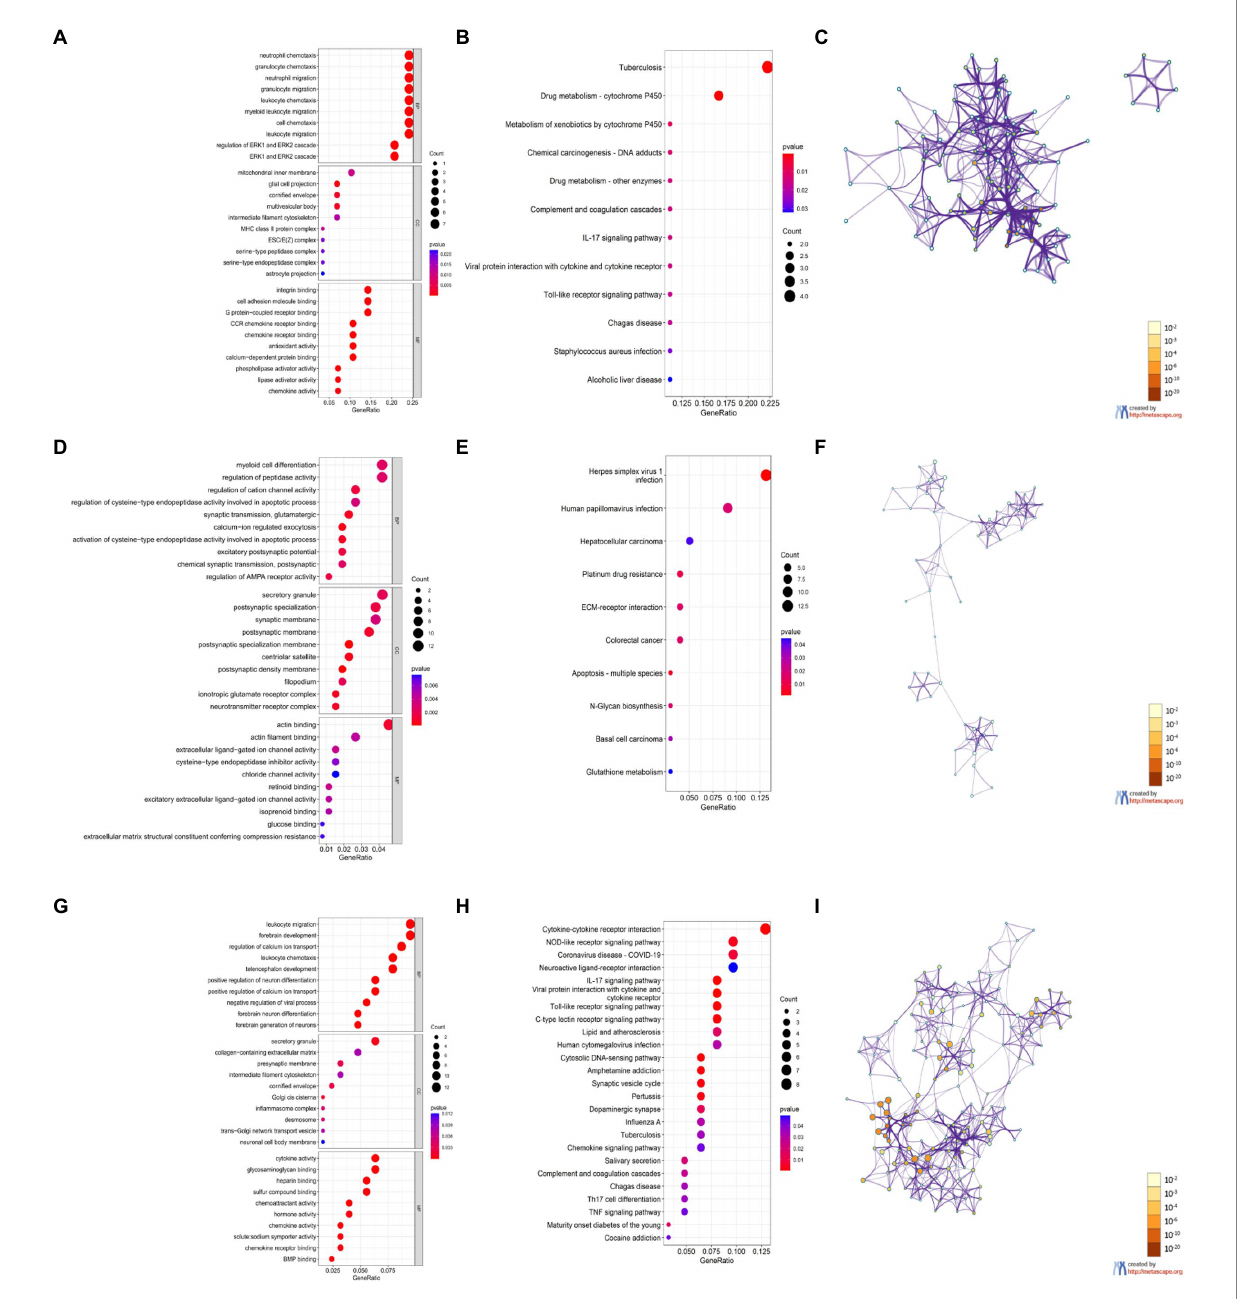
FIGURE 6 Enrichment analysis of DEGs based on R software and Metascape. (A,D,G) GO enrichment items of CX (A) , HC (D) , and CB (G) . (B,E,H) KEGG enrichment items of CX (B) , HC (E) , and CB (H) . (C,F,I) The main Networks of enrich terms of CX (C) , HC (F) , and CB (I) . A,B,D,E,G,H were generated by RGui using the clusterProfiler package. C,F,I were generated by Metascape. Statistical significance of enrichment item was set at p <